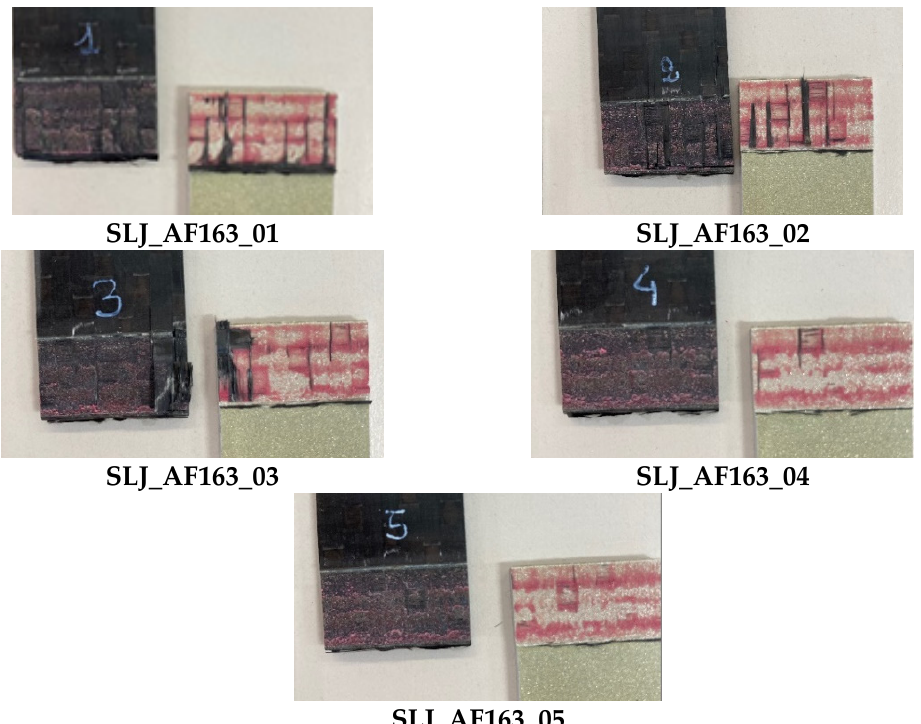
Figure 7. Highlight of failure location in SLJ_AF163 tests.